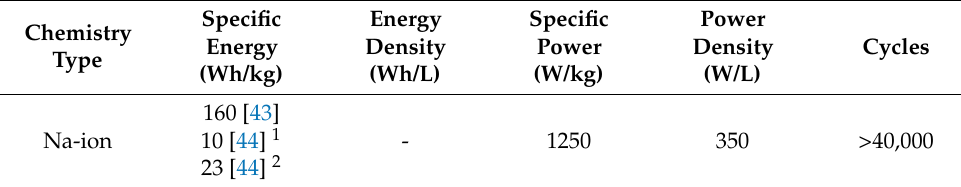
Table 4. Main characteristics of Na-ion